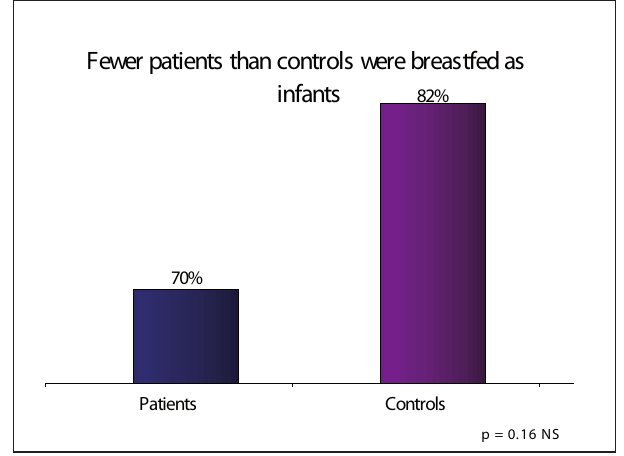
Fig. 1. Percentage of patients and controls breastfed as infants.